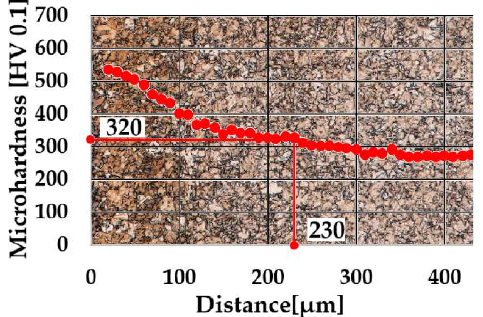
Figure 6. Microhardness profile of layer obtained by 4 h of plasma ferritic nitrocarburizing. Magnification of microstructure, 500×.